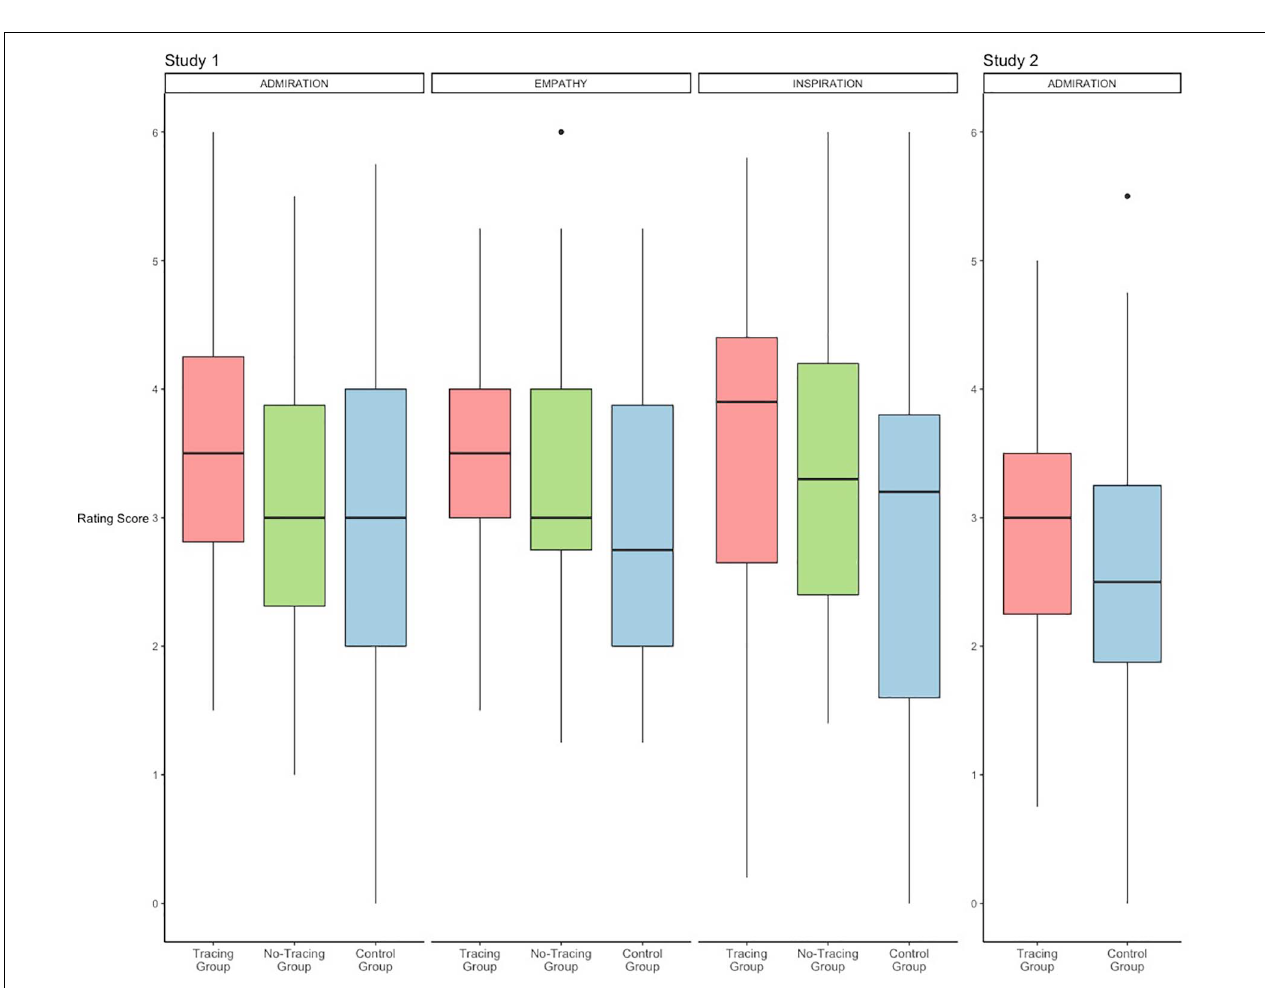
FIGURE 3 | Boxplots of rating scores in Study 1 and 2. This does not include dependent variables in which significant effects were not found.